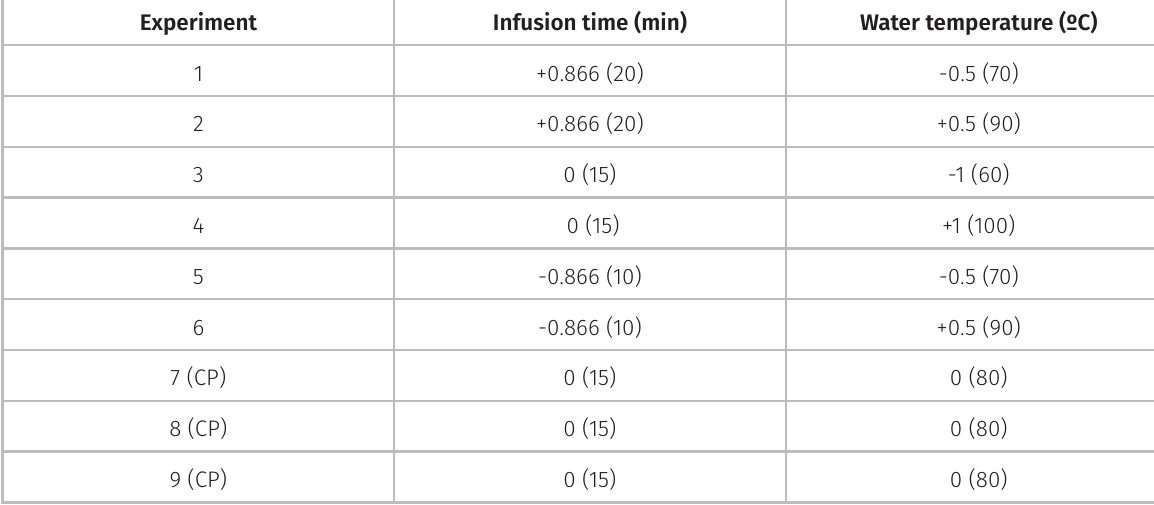
Table II. Doehlert